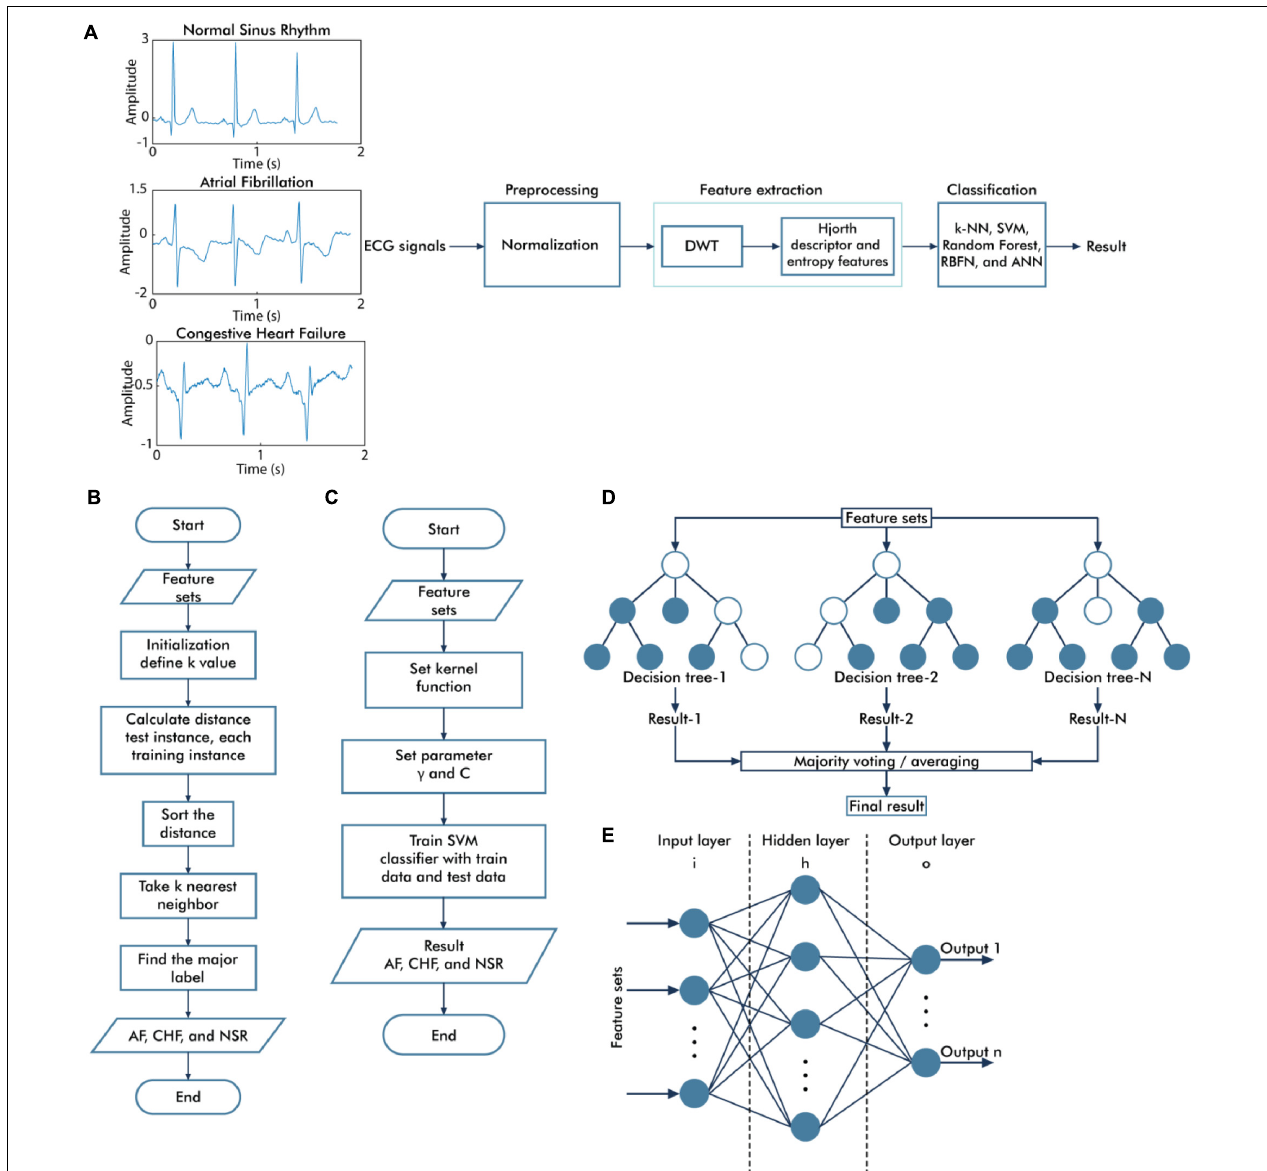
FIGURE 1 | Overall diagram of the proposed system. The general block diagram of the classification system based on discrete wavelet transform and Hjorth descriptor feature extraction (A) , the flowchart of the k -nearest neighbor algorithm (B) , the flowchart of the support vector machine algorithm (C) , the topology of random forest classifier algorithm (D) , and the architecture of neural network algorithm (E)